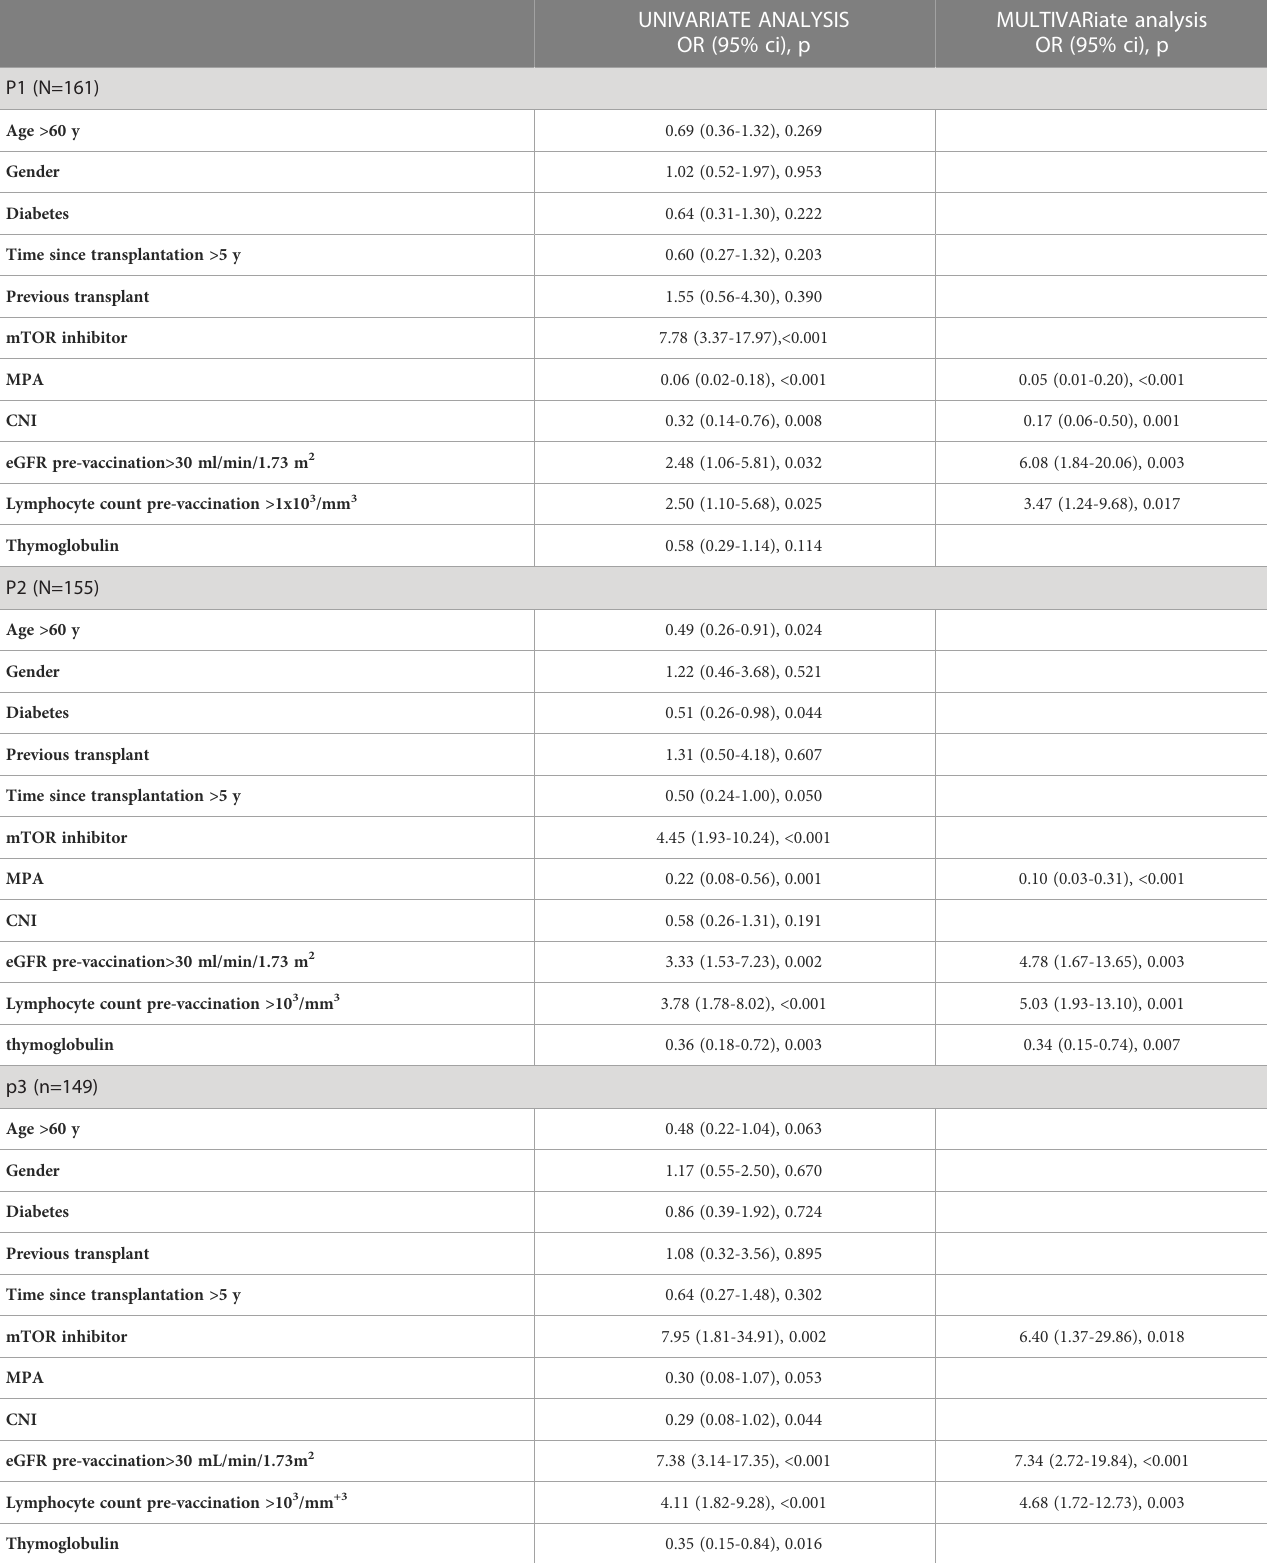
TABLE 2 Factors related to antibody respond after second and third dose of SARS-CoV-2 mRNA-1273 vaccine in COVID-19 naïve KTR.